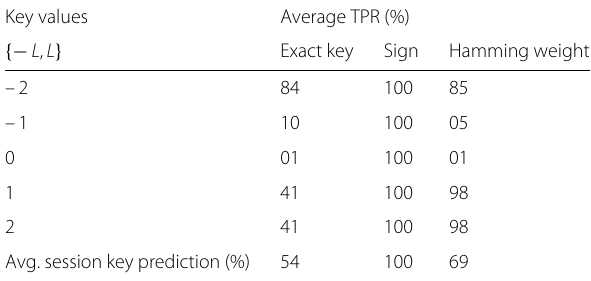
Table 2 Average TPR of session key